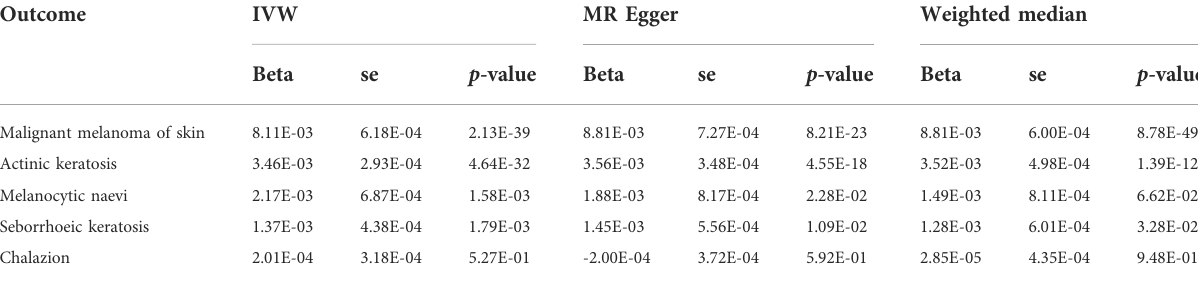
TABLE 5 MR results between tanning response to sun exposure and fi ve skin diseases in the replication